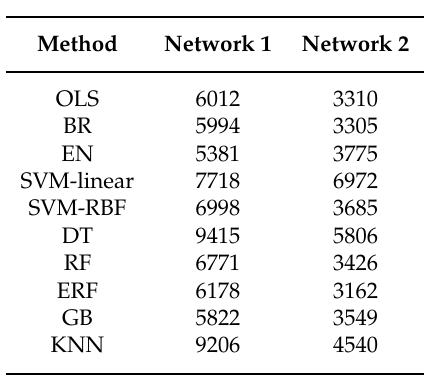
Table 2. MAPE score using all methods for the two smart grid power networks. BR, Bayesian Ridge regression.